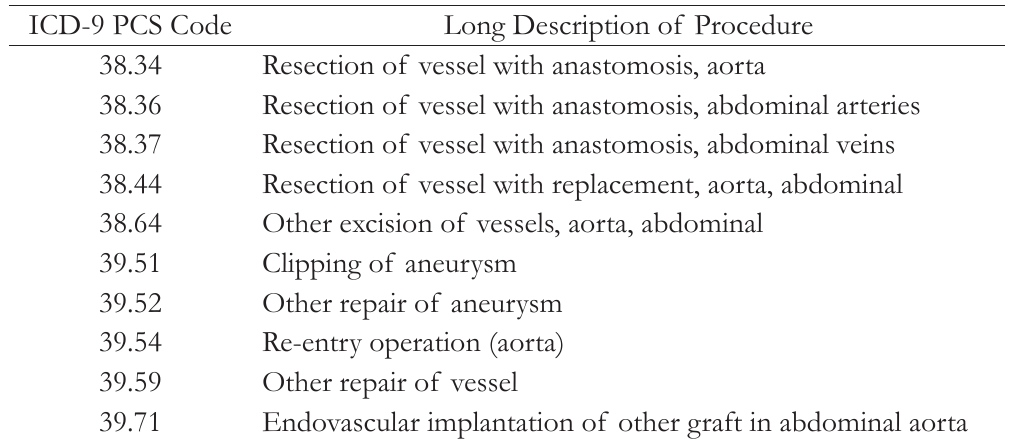
Table 1: ICD-9 PCS Discharge Codes Used to Identify Procedures for a Diagnosis of AAA or Possible AAA ICD-9 PCS